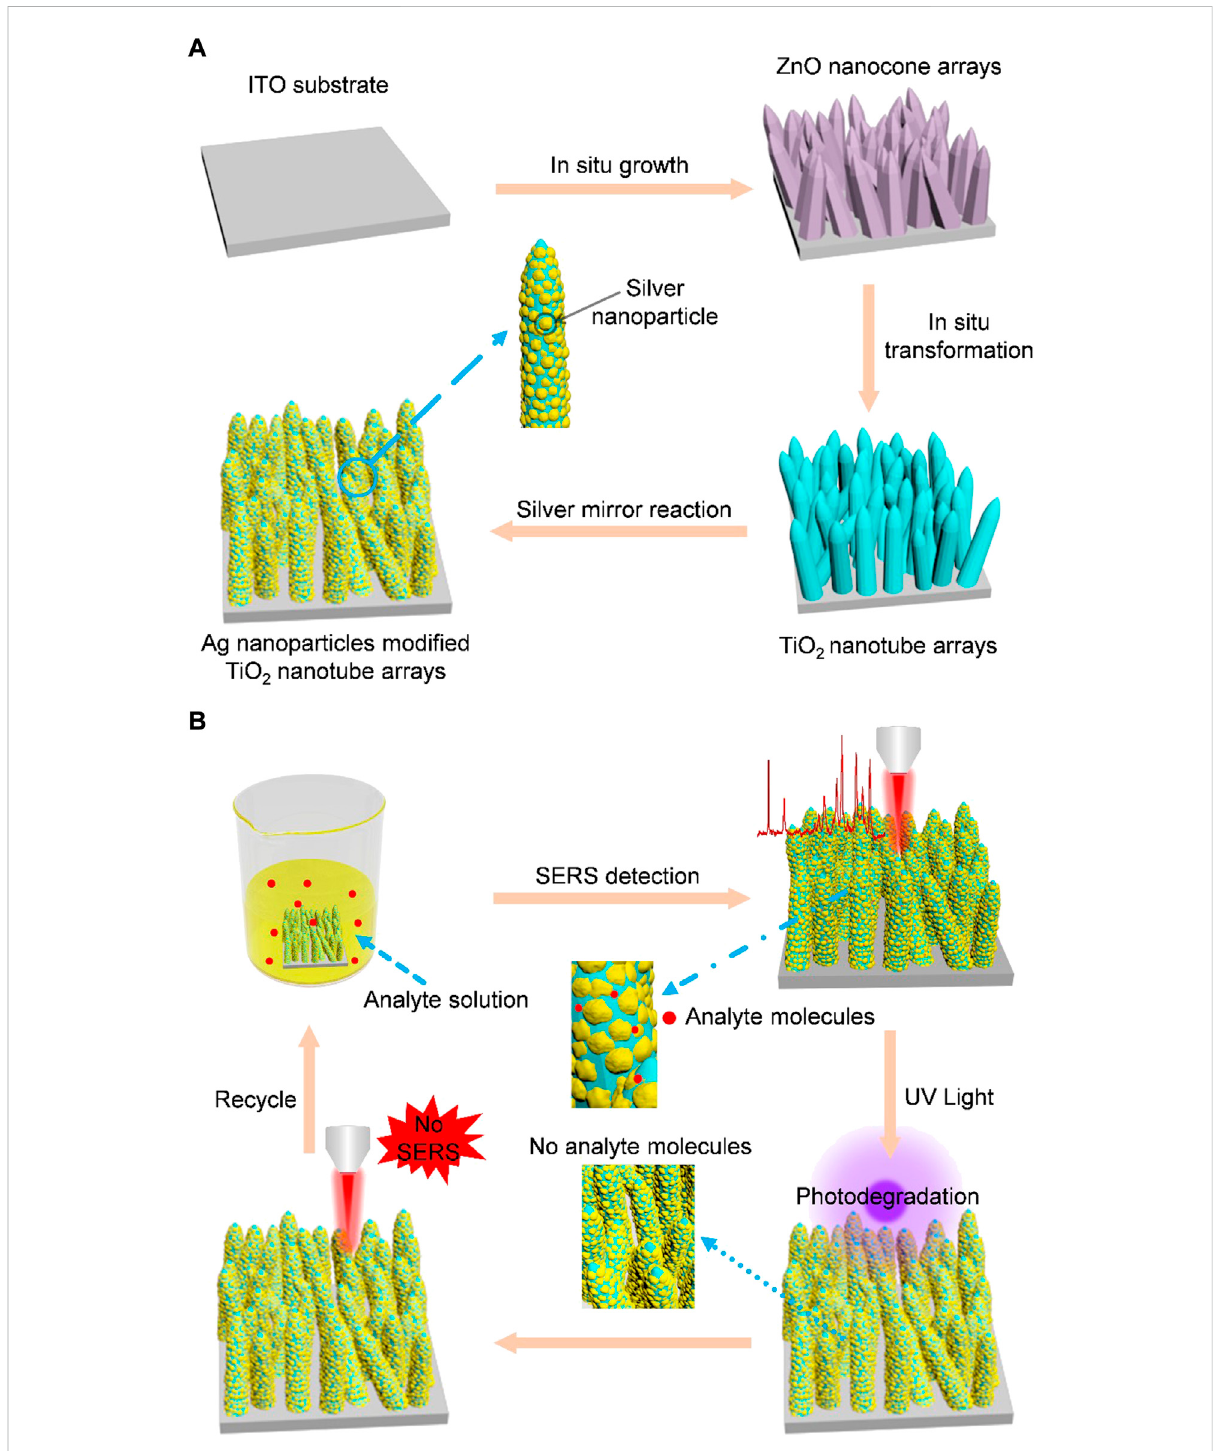
FIGURE 1 (A) SchematicforthesynthesisofAgnanoparticlesmodi fi edTiO 2 nanotubearrays.Step1:ZnOnanoconearrays aregrown onanITOglassbya hydrothermal synthesis method. Step 2: TiO 2 nanotube arrays are fabricated by immersing the as-prepared ZnO nanocones (serving as sacri fi cial templates) in an aqueous solution of (NH 4 ) 2 TiF 6 . The hydrolysis reaction-produced TiO 2 is deposited on the surface of ZnO nanocones and ZnO nanocone template is selectively etched by H + gradually in the same time, leading to the fi nal formation of TiO 2 nanotubes. Step 3: Ag nanoparticles are modi fi ed on TiO 2 nanotubes by silver mirror reaction. (B) Schematic for the self-cleaning performance of Ag nanoparticles modi fi ed TiO 2 nanotube arrays. Step 1: Analyte molecules adsorb on the fabricated SERS and SERS detection are realized. Step 2: After realization of SERS detection, the analyte molecules adsorbed on the SERS substrate are removed by photodegradation. Step 3: SERS measurement is used to prove that the analyte molecules have been removed. Step 4: The recycled SERS substrate is used for detection of molecules